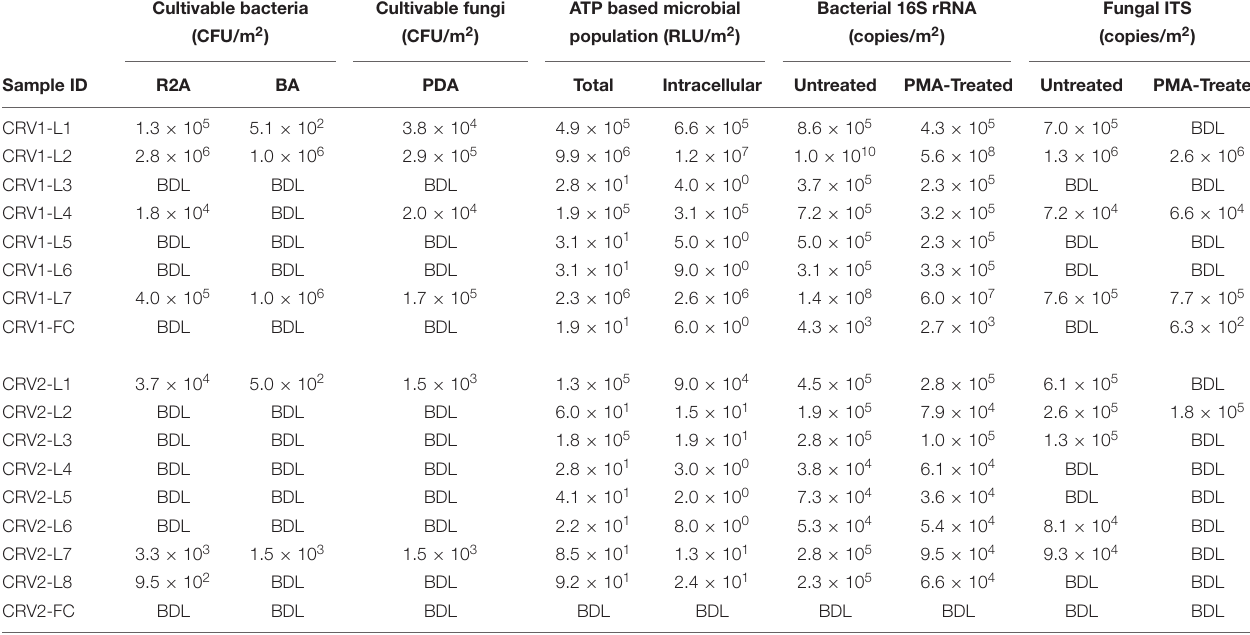
TABLE 2 | Total, viable, and cultivable microbiological characteristics of CRV system surface samples. Cultivable bacteria Cultivable fungi ATP based microbial Bacterial 16S rRNA Fungal